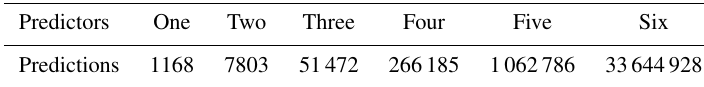
Table 2. Number of predictions possible for different numbers of predictors.